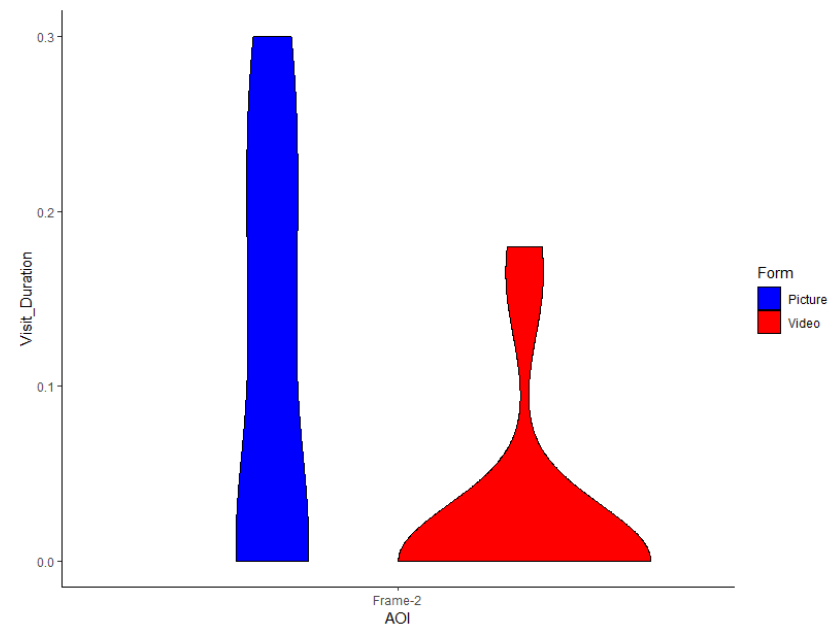
Figure 7. Violin plots highlighting the most significant differences on TVD Diff% between forms of representation for the product Stairs.